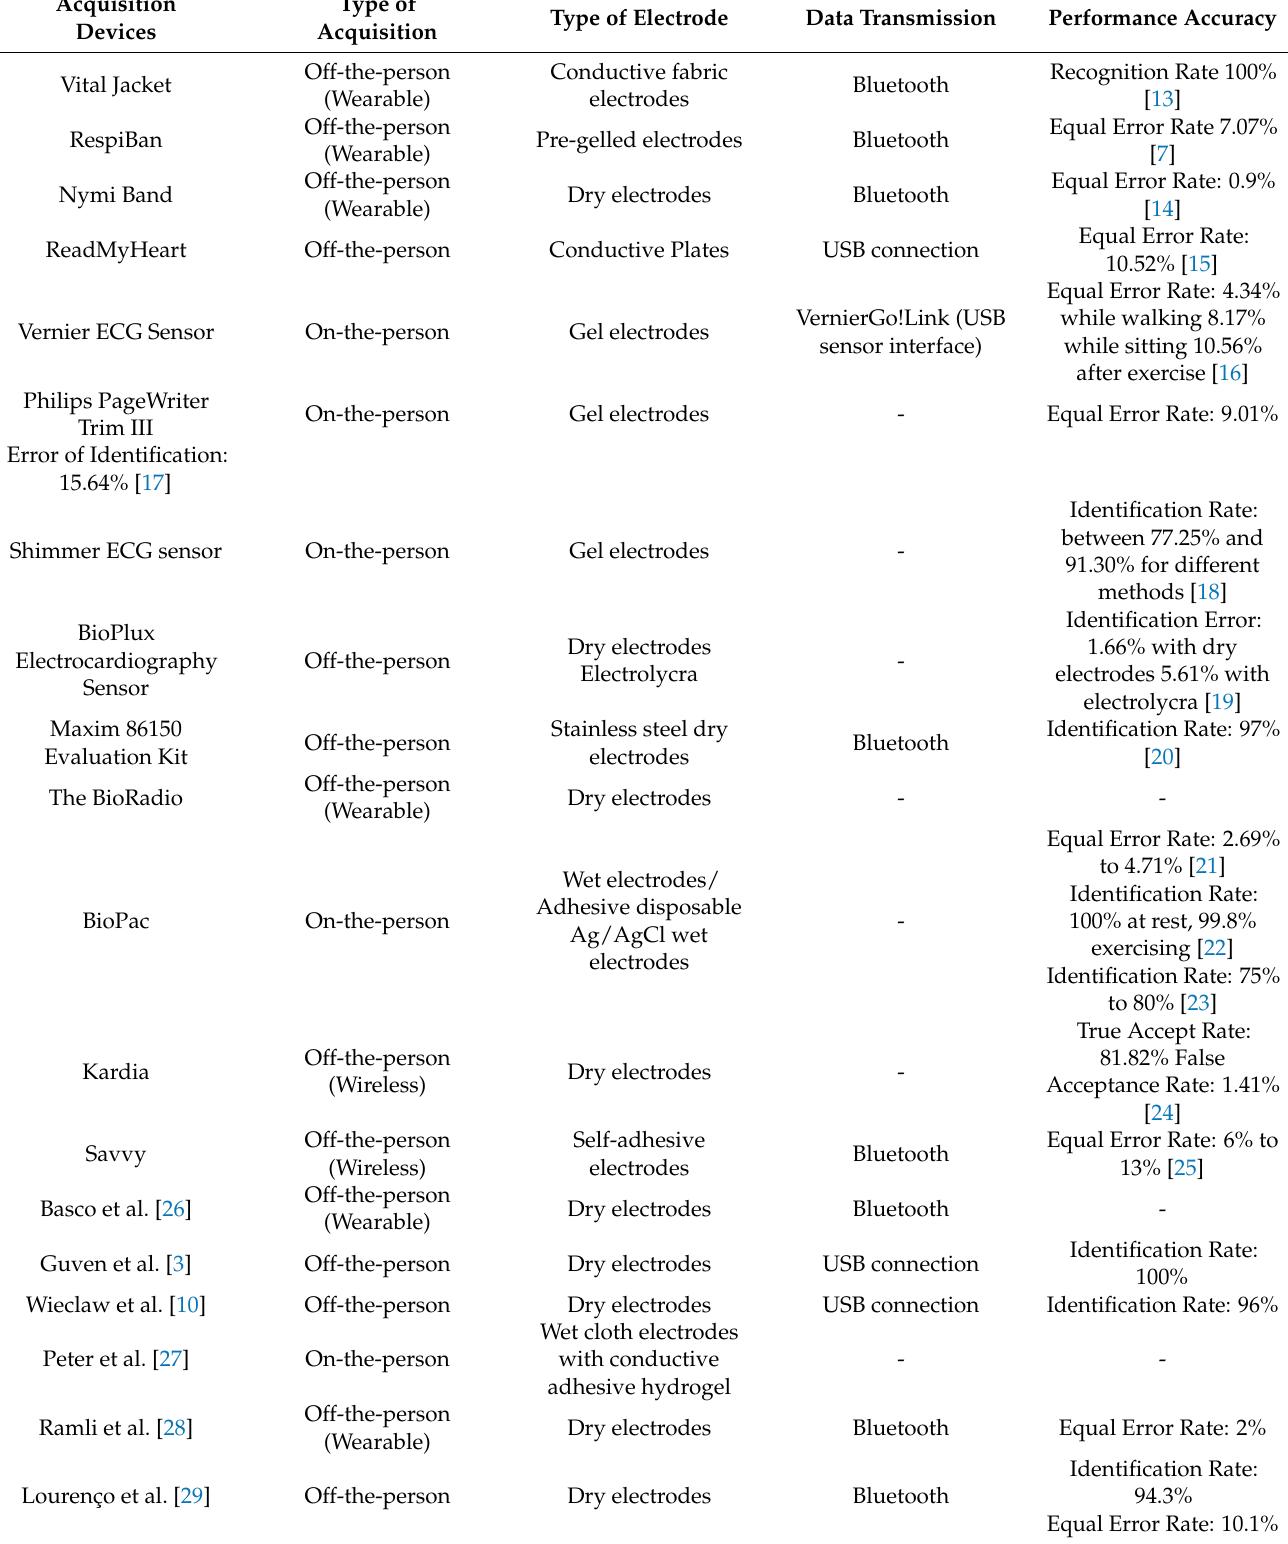
Table 1. Overview of the commercially available and self-developed